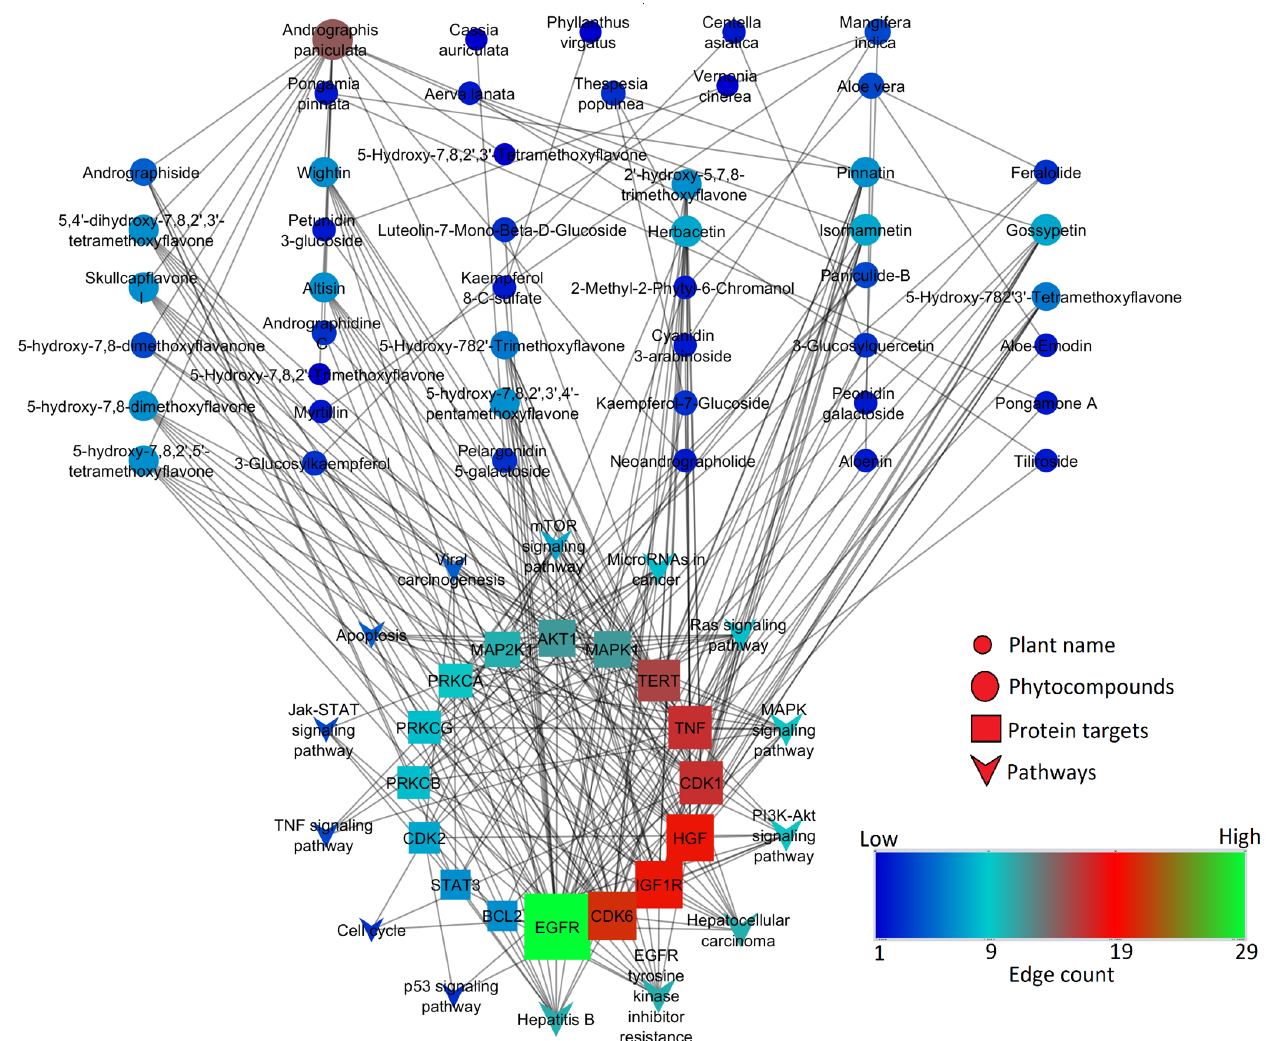
Figure 3. Network representation of herbs–phytocompounds–proteins pathways of HBV infection and HCC. The network node size “Low to High” representation is based on the degree of connection among the nodes and was analyzed by a network topological parameter “edge count”. It is highly evident that the EGFR node scored the highest edge count of 29, compared to all the other targets studied.